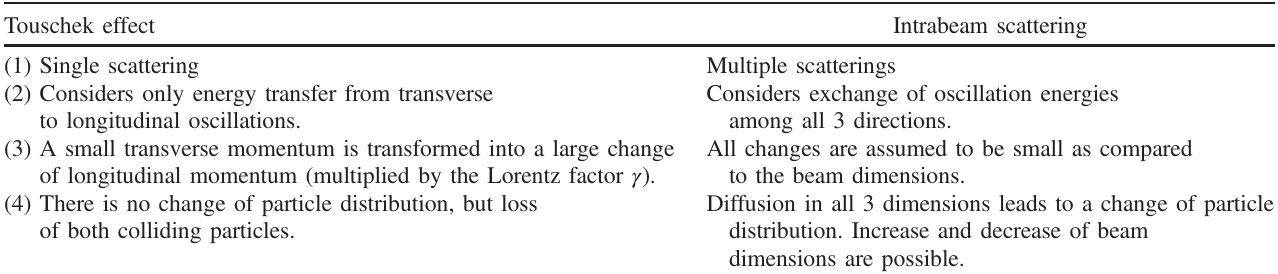
TABLE I. Coulomb scattering of particles within a beam. Touschek effect